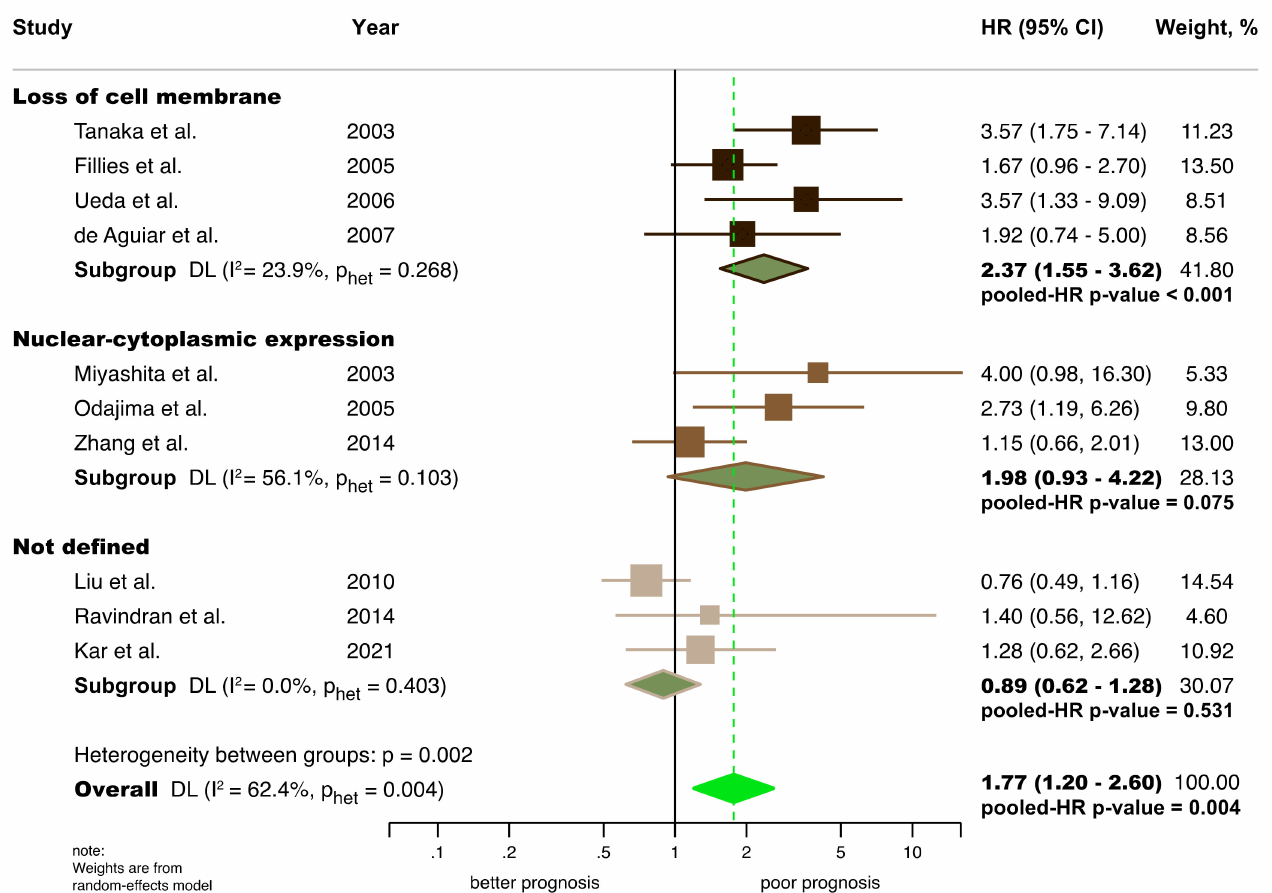
Figure 3. Forest plot of the association between the aberrant expression of β -catenin and overall survival in OSCC (random-effect model meta-analysis, inverse-variance weighting based on the DerSimonian and Laird method), stratified by subcellular location (dark brown, loss of cell mem- brane; medium brown, nuclear-cytoplasmic expression; light brown, not defined in primary level studies; green, overall pooled estimates). Ten primary-level studies were meta-analysed for this variable [40–42,46,55,56,69,71,73,76]. A HR > 1 suggests that the aberrant expression of β -catenin is associated with poor overall survival. Diamonds indicate overall HR with their corresponding 95% CIs. HR, hazard ratio; CI, confidence